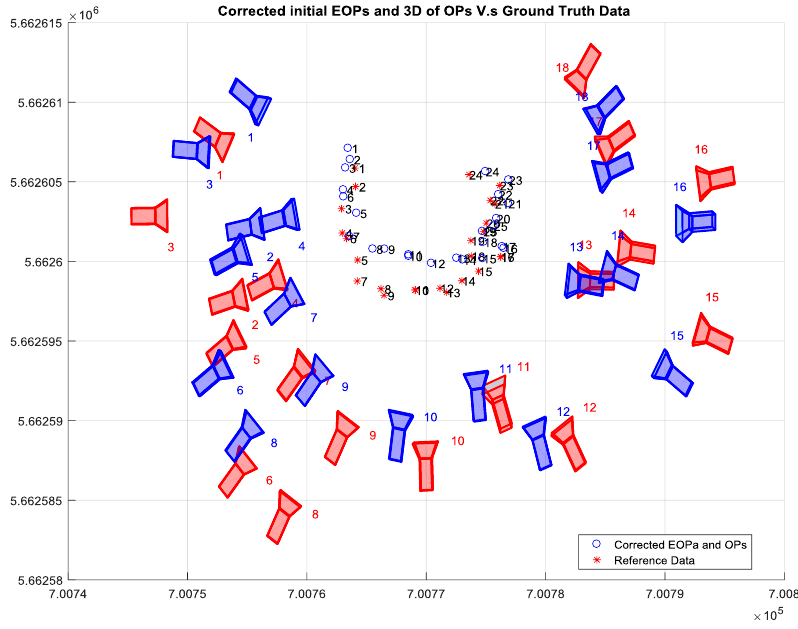
Figure 11. The final corrected initial EOPs and Ops.